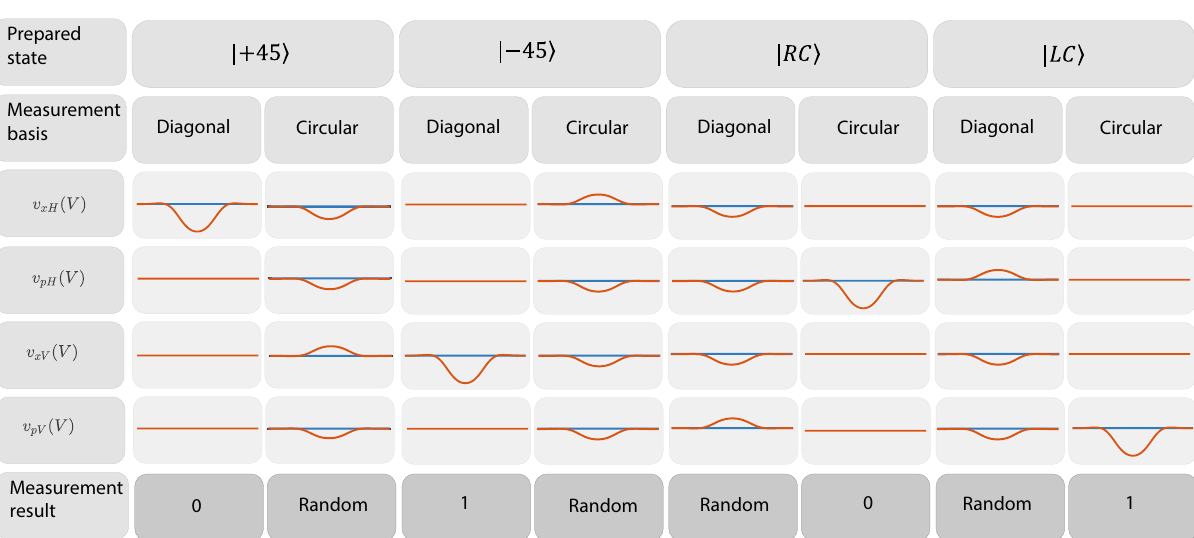
Figure 2. Transmitted frame where the pilot tone that follows a deterministic sequence alternating between RC and is time-multiplexed with the quantum data signal, which the sequence is randomly chosen between | � four possible SOPs.